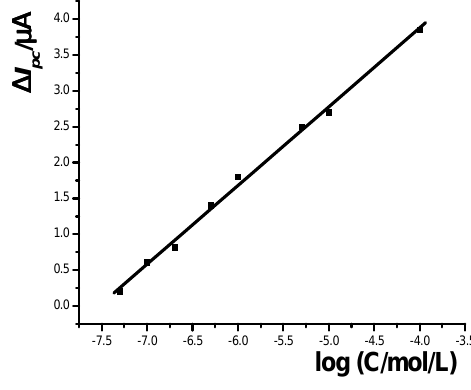
Figure 5. Calibration curve for the ssDNA sequence detection.